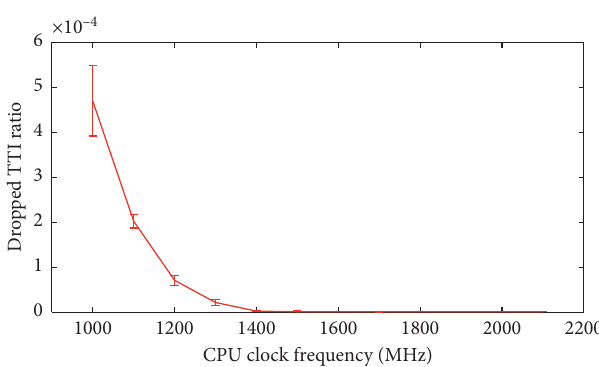
Figure 6: System 1: dropped TTI ratio for each clock frequency value recorded. The red line is the median with the vertical bars depicting ± one standard deviation. 10 MHz bandwidth with 25 RB